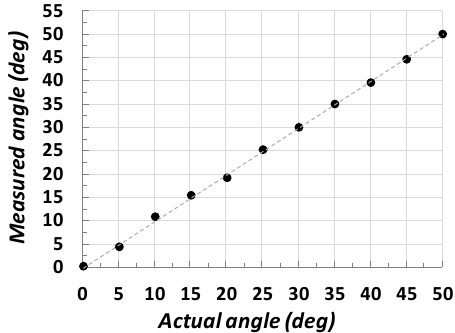
Figure 9. Obtained measurements applying the proposed model to detect rotations (Equation (5)).